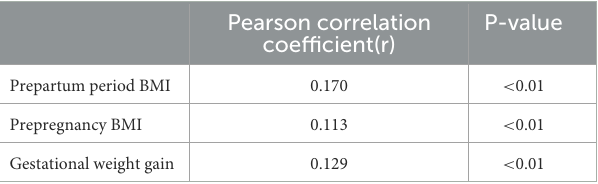
TABLE 3 Relationships between birth weight and gestational weight gain, prepartum period BMI, pre-pregnancy BMI in infants born with GDM mother ( N =